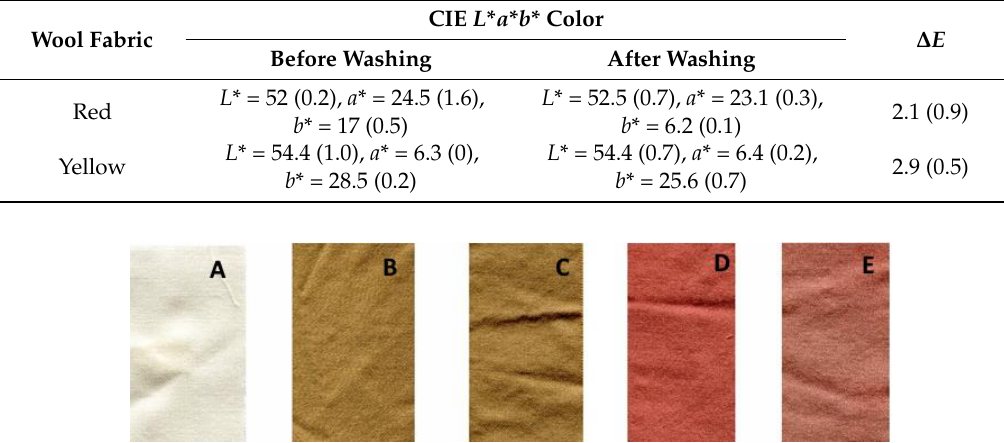
Figure 1. Wool samples dyed with dyes from P. murcianum and T. australis , before and after washing: ( A ) Control, ( B ) Sample dyed with P. murcianum dyes, ( C ) Sample dyed with P. murcianum dyes after washing, ( D ) Sample dyed with T. australis dyes, ( E ) Sample dyed with T. australis dyes after washing.